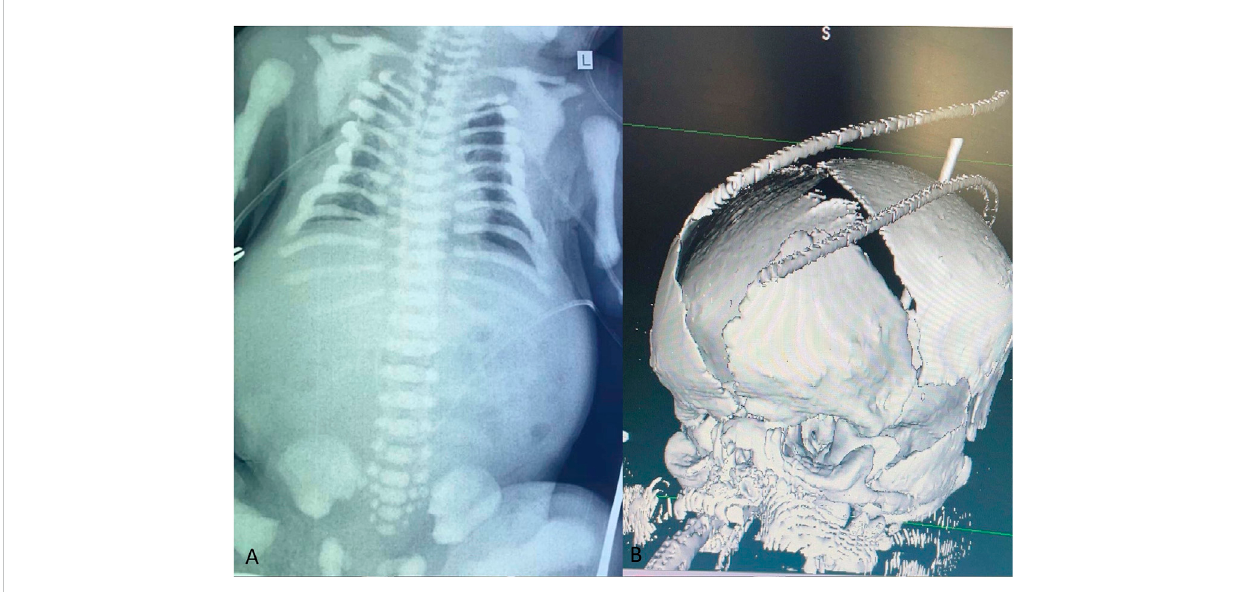
FIGURE 2 The chest X-ray in anteroposterior view indicates increased bone density in the ribs, vertebrae, scapulae, clavicles, humeri, and pelvis, which suggests the presence of generalized osteosclerosis (A) . The brain three-dimensional CT scan reveals a widely open anterior fontanelle (B)